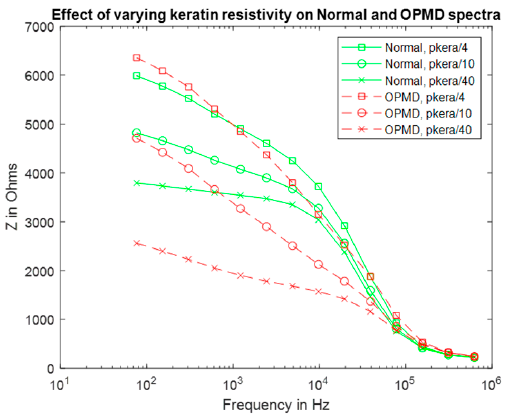
Figure 8. Real impedance spectra for normal and OPMD oral tissue according to keratinised layer resistivities (pkera).